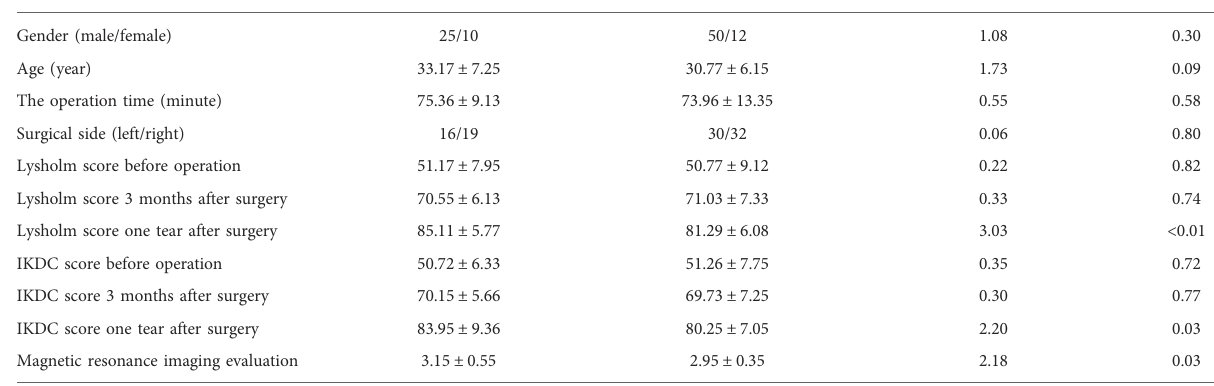
TABLE 2 Demographic data and clinical